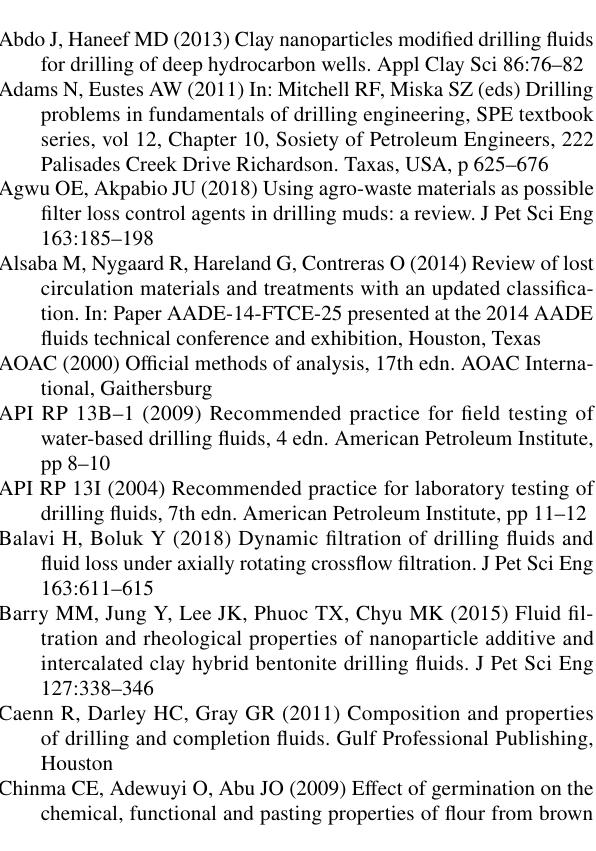
Fig. 6 Filtration volume plotted against the square root of